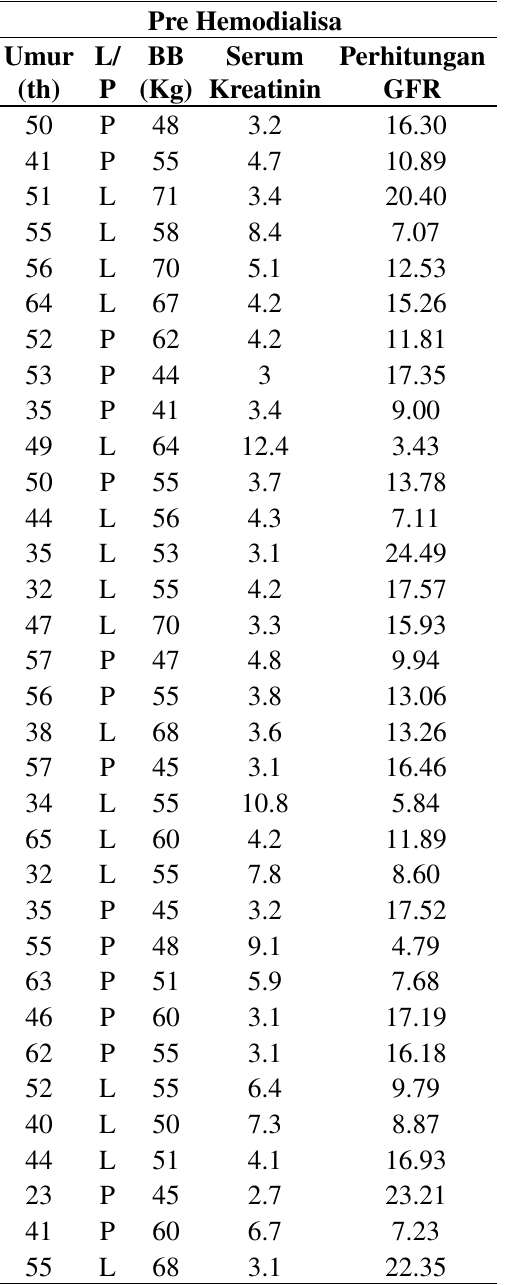
Tabel 2. Distribusi frekuensi GFR